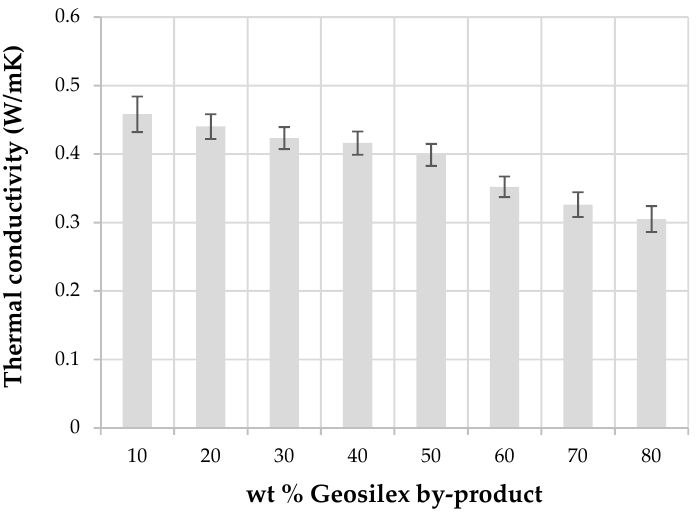
Figure 11. Thermal conductivity of the xWBA-yG calcium silicate units as function of G by-product content.